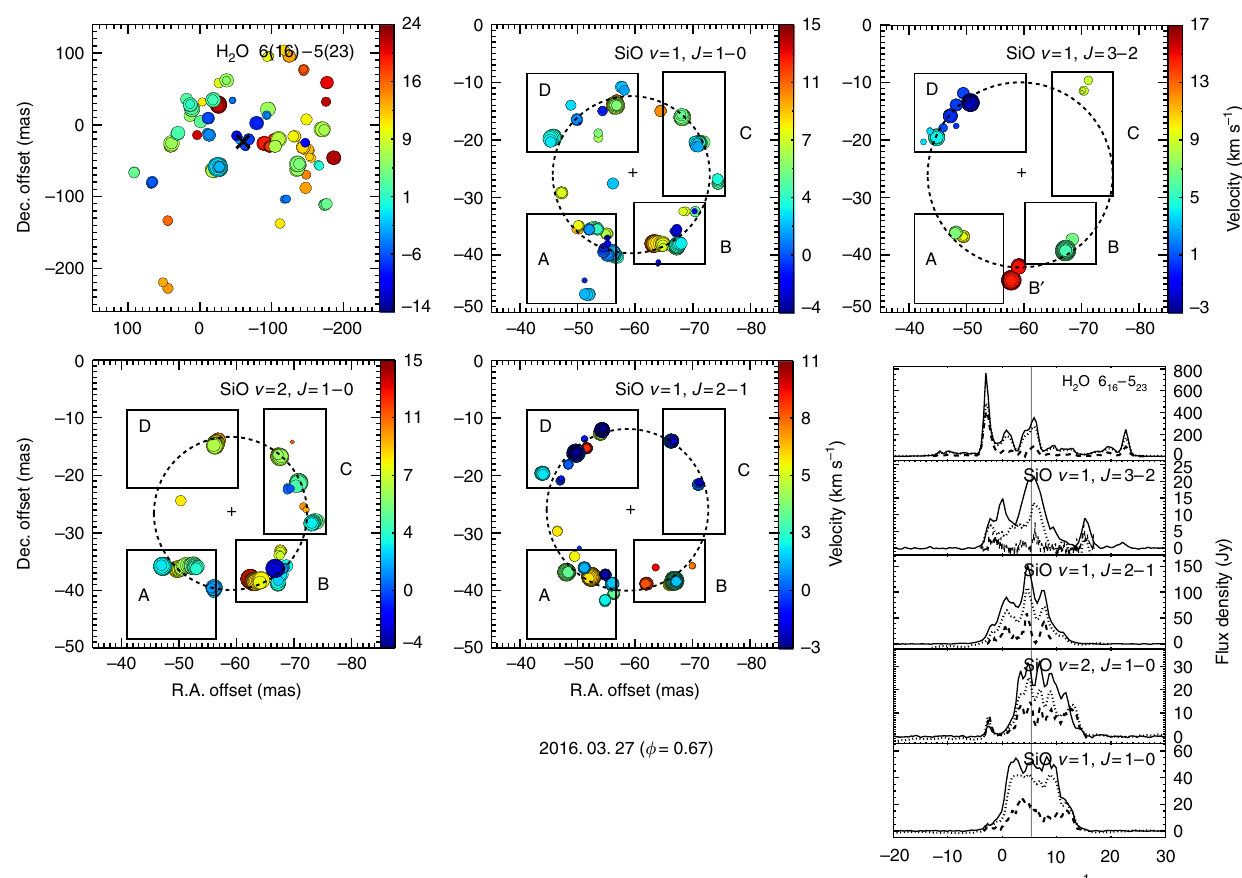
Fig. 2 The position – velocity spot maps and fl ux spectra. The color of the spot indicates the local-standard-of-rest velocity and the size of spot the logarithmic scale of the intensity. The dashed circle is the ring fi tted to the SiO maser spot distribution. The center of each ring is marked with “ + ” . The position of the central star is marked with “ x ” on the H 2 O distribution and assumed to be the ring center of all four SiO maser lines combined in Fig. 3. The spectra represent the single dish (solid, April 5, 2016), total power (dotted), and recovered fl ux (dashed) in VLBI observations (Method). The gray vertical line represents the stellar velocity (5.3 kms − 1 ) 5